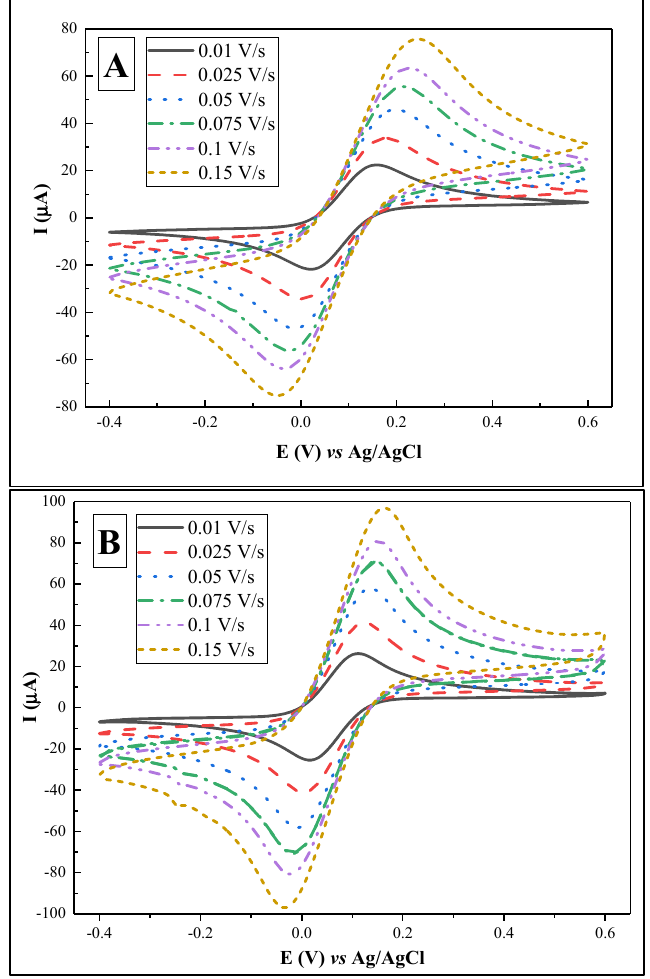
Figure 4. Cyclic voltammograms for SPCE ( A ) and SPCE/AuNS ( B ) at scan rates of 0.01, 0.025, 0.05, 0.075, 0.1, and 0.15 V/s in PBS, pH 7.4, containing 2 mM [Fe(CN 6 )] 3 − /4 − . Table 1. Experimental data obtained from CV at different scan rates for SPCE and SPCE/AuNS. Error bars were calculated as a percentage of standard error. SPCE SPCE/AuNS Scan Rate, V/s